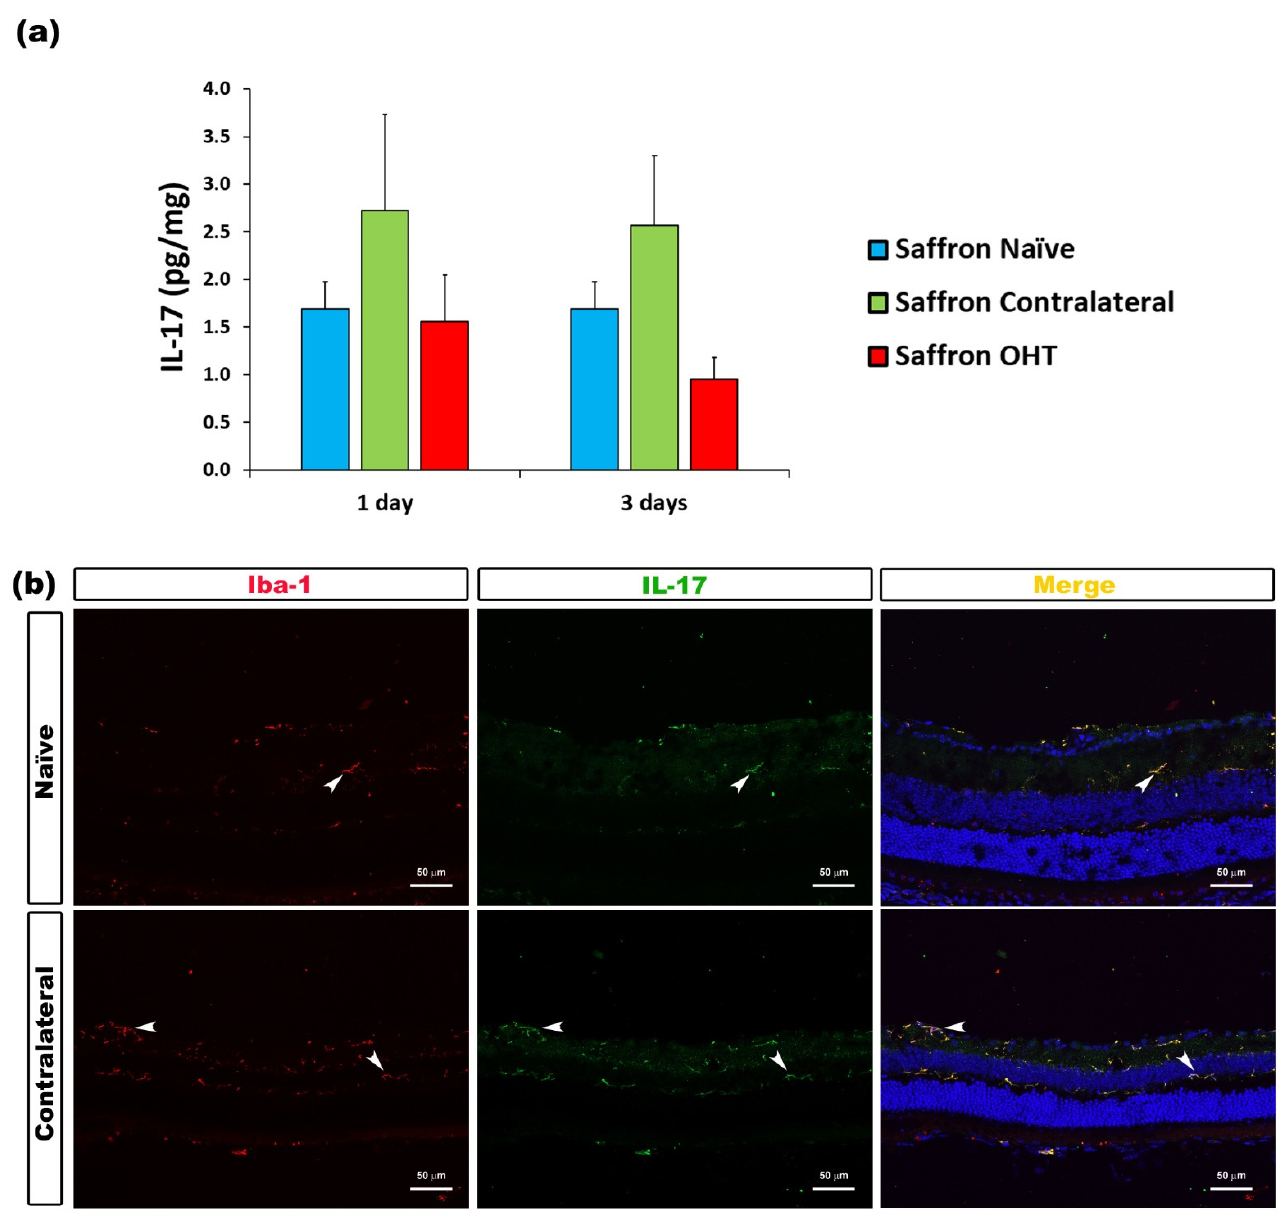
Figure 5. IL-17 levels at 1 and 3 days after laser-induced ocular hypertension (OHT). ( a ) The IL-17 values obtained in the multiplex assay. The histogram shows the mean levels (±SD) of IL-17 (pg/mg) at days 1 and 3 after laser OHT induction in saffron ocular hypertension eyes (saffron OHT), saffron-contralateral eyes (saffron-contralateral), and naïve eyes. ( b ) Immunohistochemical study of IL-17 expression in saffron-contralateral eyes one day after unilateral laser-induced OHT. Retinal sections were immunolabeled with antibodies to IL-17 (green) and Iba-1 (red). Merge is denoted by the colour yellow. The arrowhead shows the co-expression of Iba-1 and IL-17 in saffron-contralateral and saffron-naïve eyes. Abbre-